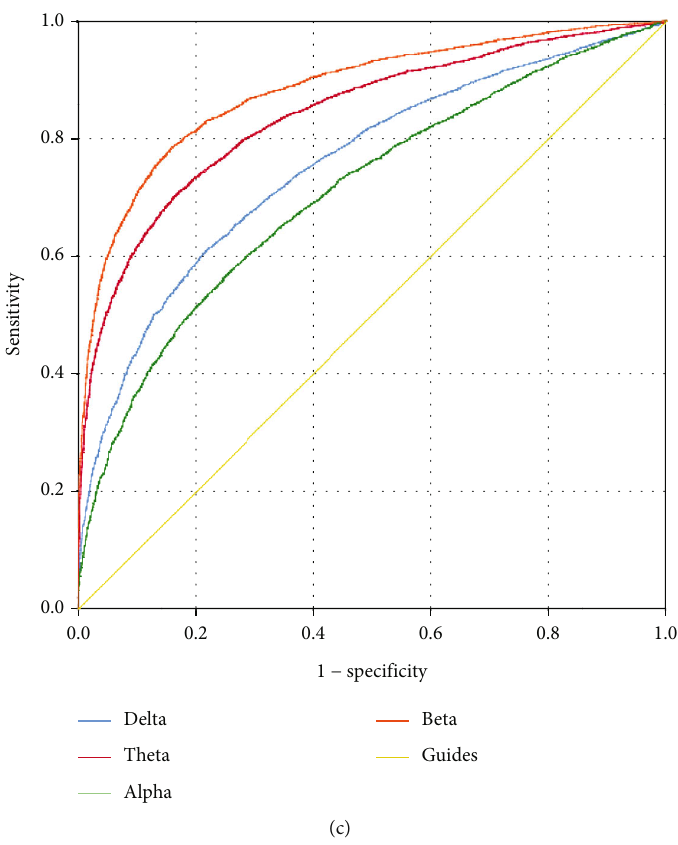
Figure 10: ROC curves for di ff erent connectivity metrics. (a) ROC curve of Granger ’ s causality. AUC = 0 : 0995 (95% CI 0.004-0.996 P < 0 : 01 ). (b) ROC curve of the Pearson r . Delta AUC = 0 : 557 (95% CI 0.540-0.573 P < 0 : 01 ), theta AUC = 0 : 627 (95% CI 0.611-0.643 P < 0 : 01 ), alpha AUC = 0 : 740 (95% CI 0.726-0.754 P < 0 : 01 ), and beta AUC = 0 : 497 (95% CI 0.480-0.513 P = 0 : 71 ). (c) ROC curve of PTE. Delta AUC = 0 : 756 (95% CI 0.746-0.766 P < 0 : 01 ), theta AUC = 0 : 841 (95% CI 0.833-0.849 P < 0 : 01 ), alpha AUC = 0 : 711 (95% CI 0.700-0.721 P < 0 : 01 ), and beta AUC = 0 : 883 (95% CI 0.876-0.890 P < 0 : 01 ). (ROC: receiver operating characteristic curve; AUC: area under curve; PTE: phase transfer